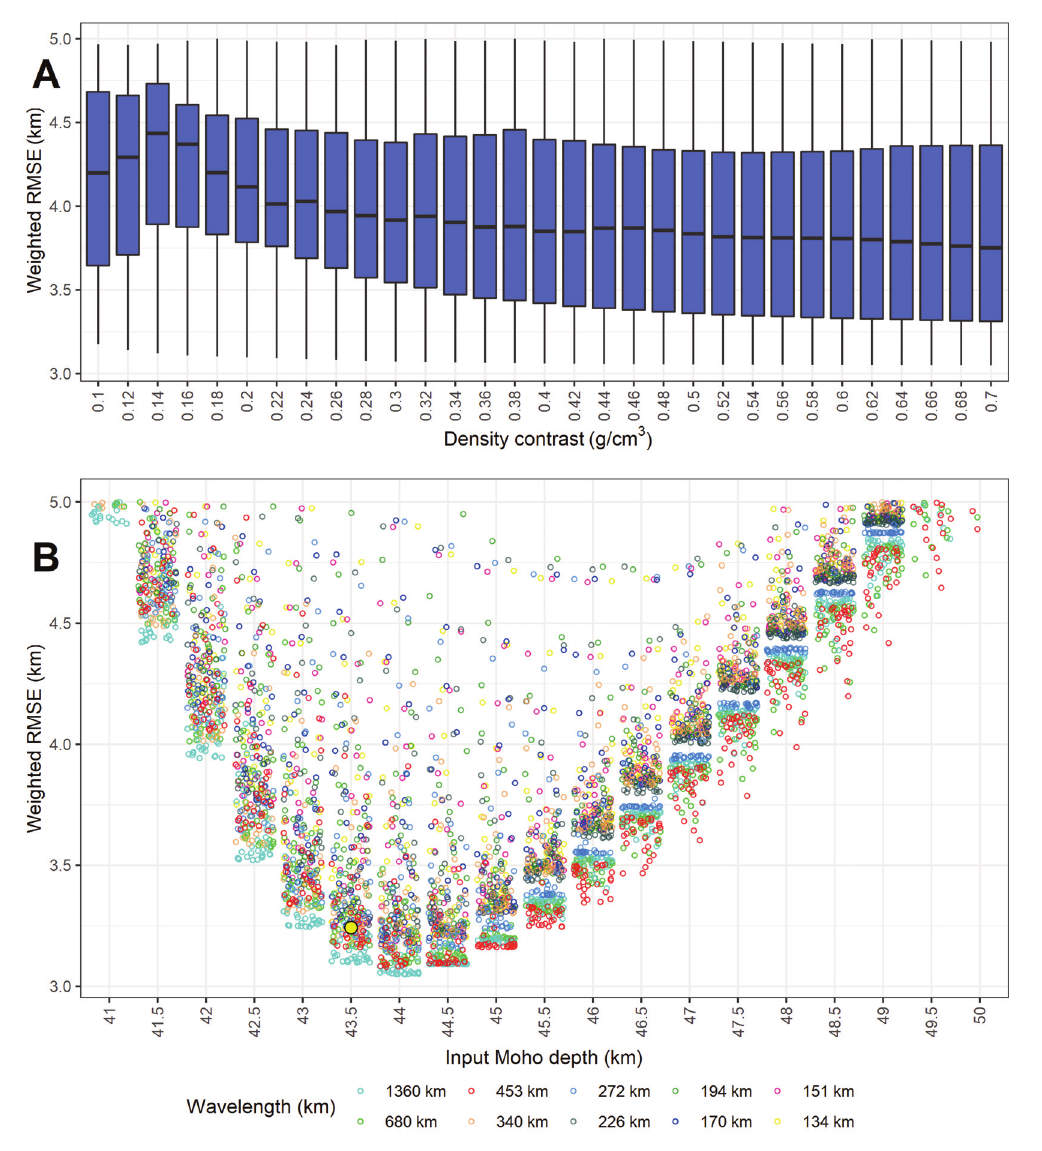
Fig. 5. Weighted RMSE in relation to modelling parameters. A , density contrast; B , filter wavelength and input depth. The large yellow dot marks the selected model. All models with weighted RSME ≥5 km are not